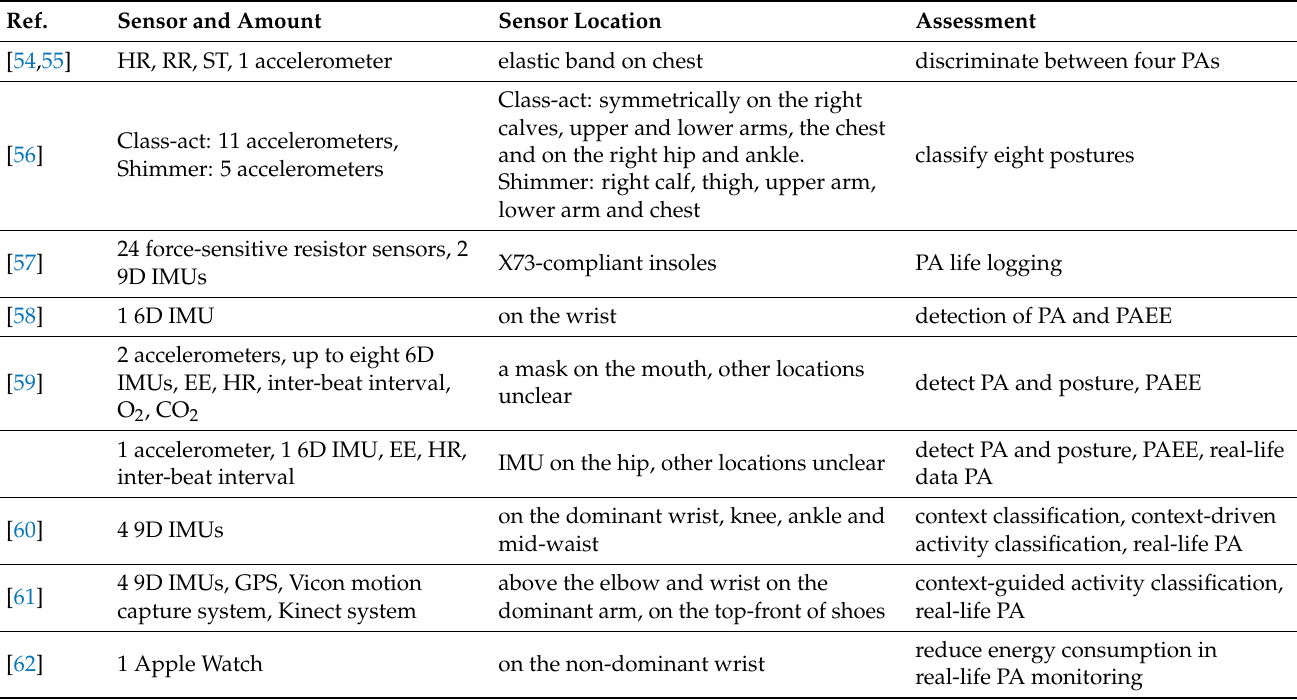
Table 6. Study characteristics for studies on physical activity